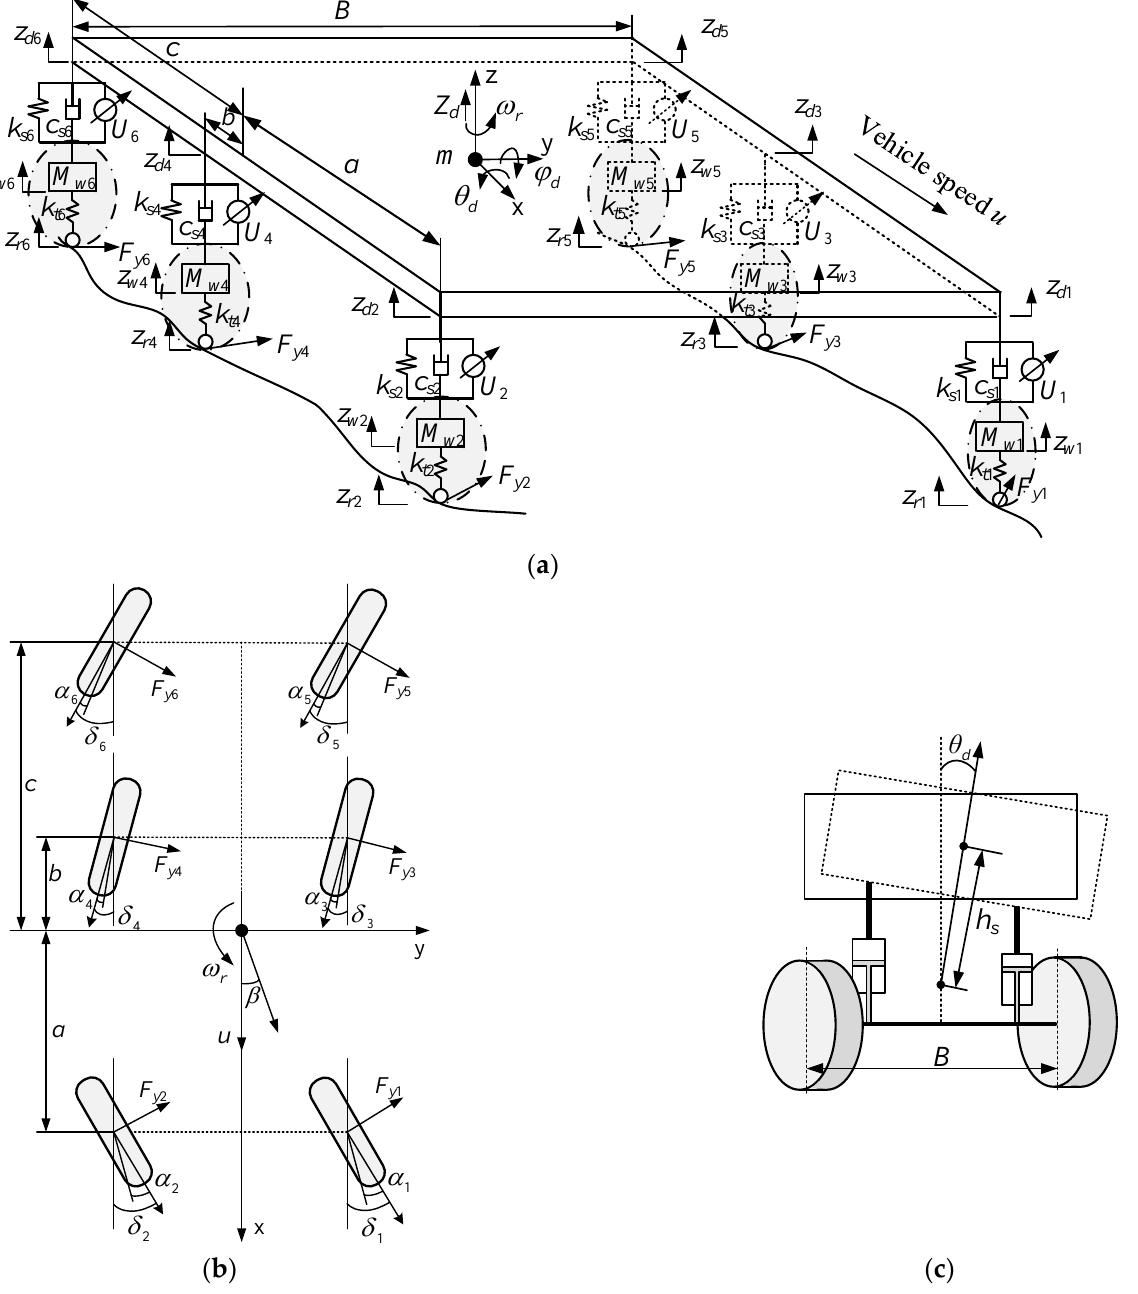
Figure 2. 11-DOF model of steering and suspension system coupling: ( a ) 11-DOF model of three-axle vehicle; ( b ) top view of the model; ( c ) front view of the